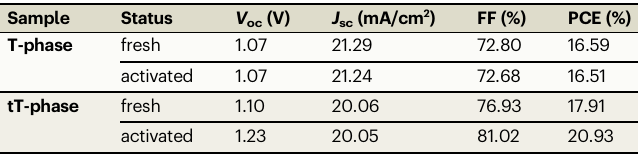
Table 1 | Photovoltaic parameters of T-phase and tT-phase